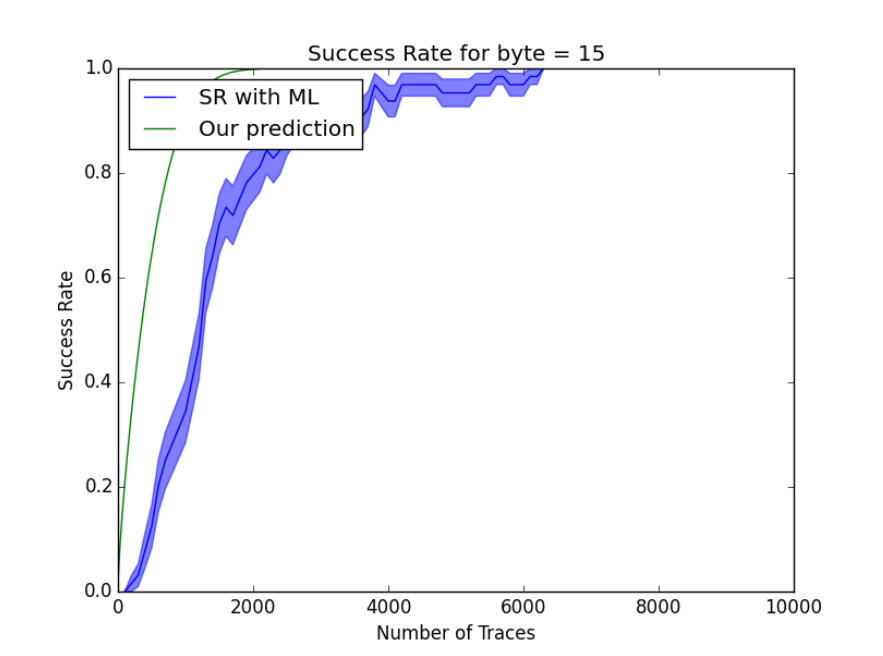
Figure 12: Success Rate vs. our prediction for the 16th byte of the secret